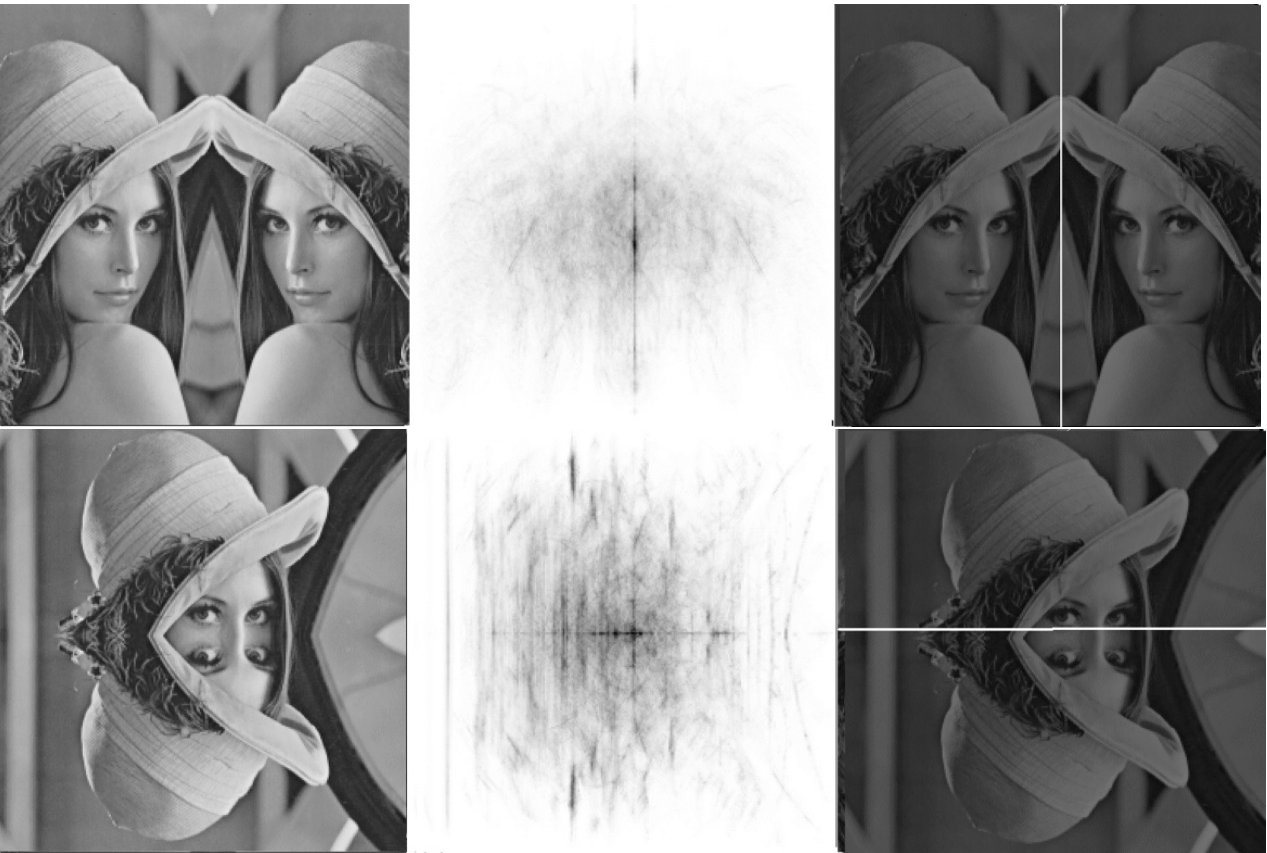
Figur e 4. Symmetry of mirrored images with the originals on the left, detected symmetry in the centre and the resulting axes of symmetry superimposed over the original on the